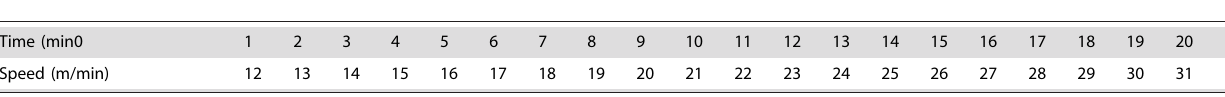
Table 2. Aerobic test protocol at weeks 1and 8 of the